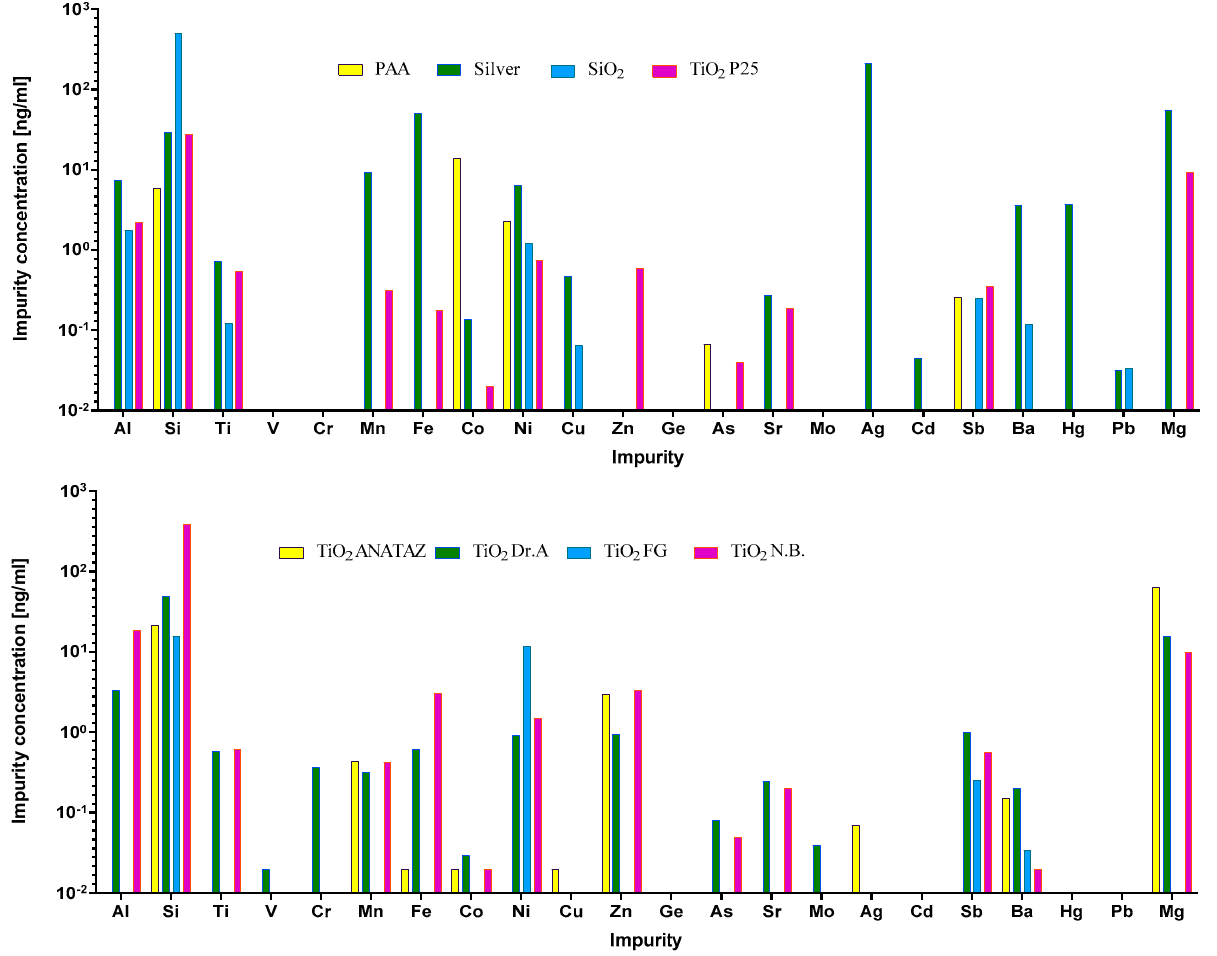
Figure 2. ICP-MS analysis of the inorganic impurities (Al, Si, Ti, V, Cr, Mn, Fe, Co, Ni, Cu, Zn, Ge, As, Sr, Mo, Ag, Cd, Sb, Ba, Hg, and Pb) detected in NP suspensions after 24 h of leaching in 0.9% ( m / v ) NaCl. The measured concentrations of the elements are given in ng mL − 1 .